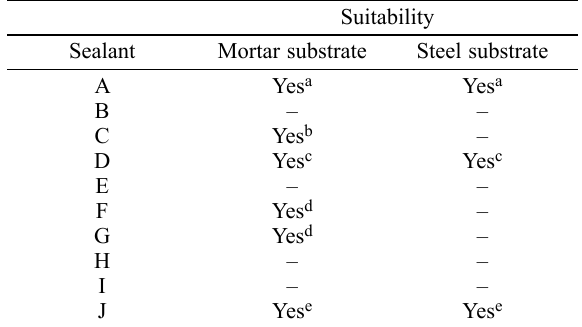
Table 5. Preliminary classification of FMS for specific suitability